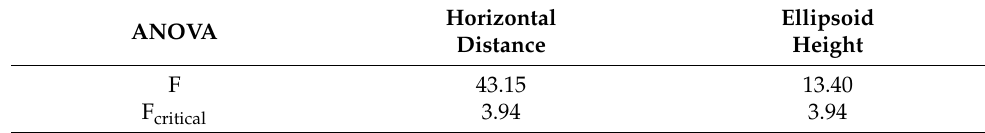
Table 9. Comparison of the horizontal distance and ellipsoid height with the ANOVA statistical